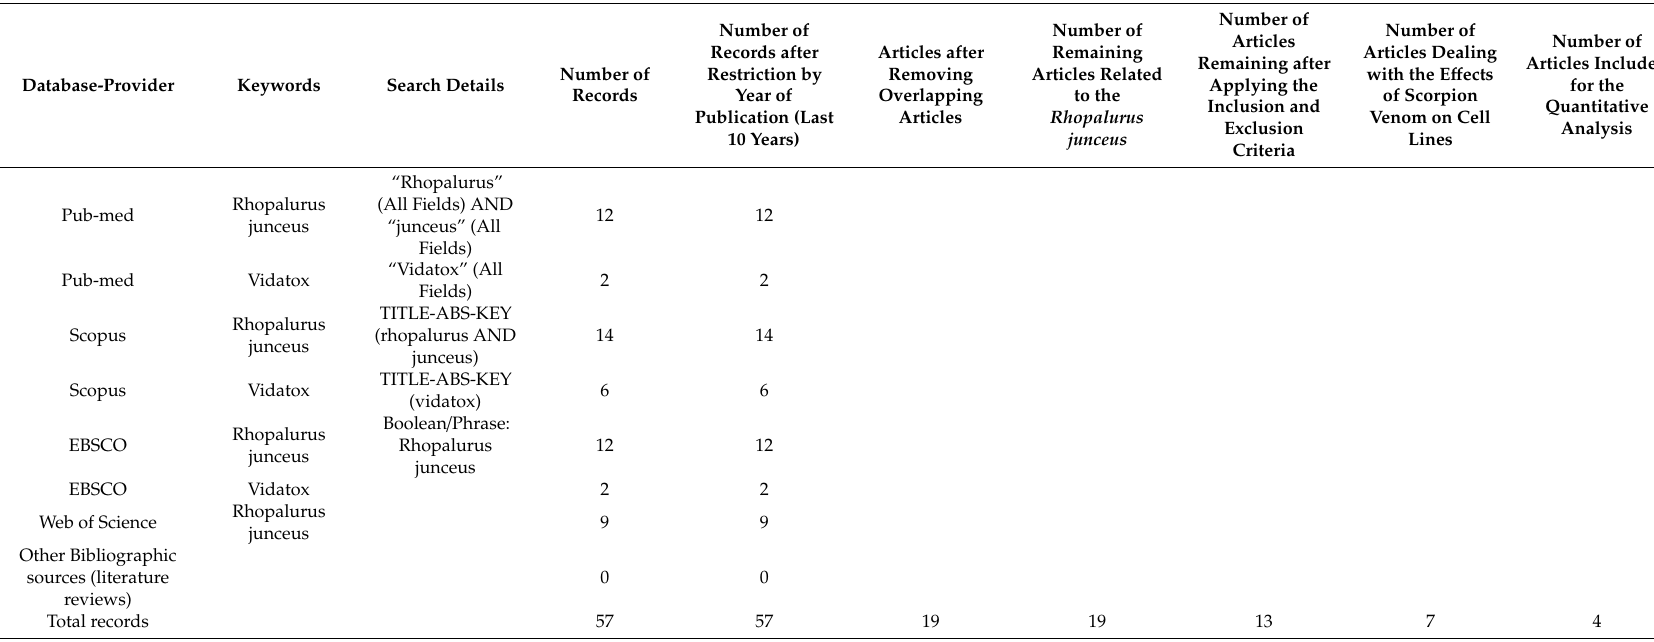
Table 1. Complete overview of the search methodology. Records identified by databases: 57. The overlaps were removed using the EndNote 8 software, and there were four articles selected for quantitative